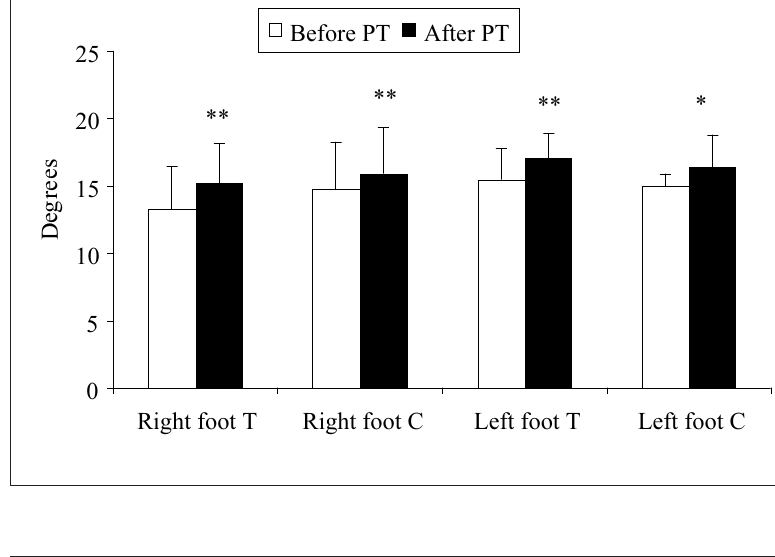
Figure 1. Changes in feet extension measures observed in the control (C) and the test (T)